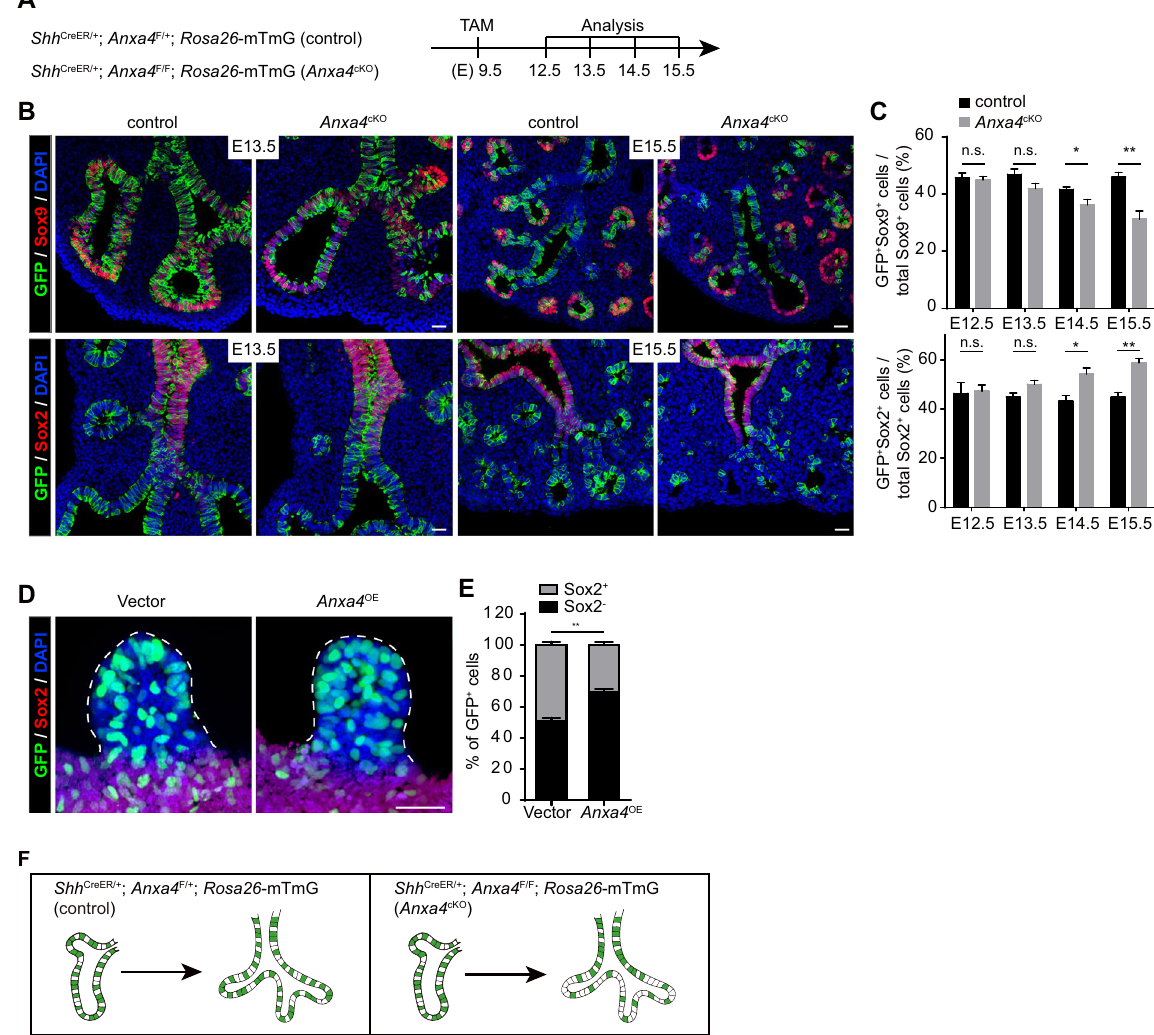
Figure 4. Anxa4 promotes distal airway epithelial cell fate commitment. ( A ) Pregnant females carrying Shh CreER/ + ; Anxa4 F/ + ; Rosa26 -mTmG (control) and Shh CreER/ + ; Anxa4 F/F ; Rosa26 -mTmG ( Anxa4 cKO ) embryos were treated with tamoxifen (TAM) at E9.5 and lungs were analyzed at different time point from E12.5 to E15.5. ( B , C ) Lungs at different time points from E12.5 to E15.5 were double stained for antibodies against GFP (green) and Sox9 (red), or GFP (green) and Sox2 (red) ( B ). Note that the proportion of GFP + cells in distal airways (Sox9 + ) of Anxa4 cKO lungs decreased over time as compared to that of control lungs, while the proportion of GFP + cells in stalk airways (Sox2 + ) of Anxa4 cKO lungs increased over time ( C ). Data are presented as mean ± S.E.M, n = 4. n.s., not significant; * p < 0.05; ** p < 0.01; Student’s t-test. Scale bar: 25 μ m. ( D , E ) GFP (green) and Sox2 (red) staining in cultured whole lung endoderm explants infected with vector or Anxa4 OE lentivirus ( D ). GFP is a reporter used to indicate lentivirus-infected epithelial cells. More GFP + cells were located in the bud tips (Sox2 − ) in Anxa4 OE lung endoderm explants than in control explants ( E ). Data are presented as mean ± S.E.M, n = 3. ** p < 0.01; Student’s t -test. Scale bar: 25 μ m. ( F ) A model illustrating the effect of loss of Anxa4 on epithelial cell behavior and cell fate. At E11.5, in both control and Anxa4 cKO lung, mosaic labeled GFP cells are evenly distributed along the airways. Four days later (E15.5), in newly formed airways of control lung, GFP + cells are still evenly distributed along the airways; however, in the newly formed airways of Anxa4 cKO lung, GFP + ( Anxa4 − / − ) cells tend to lag behind and contribute to the stalk